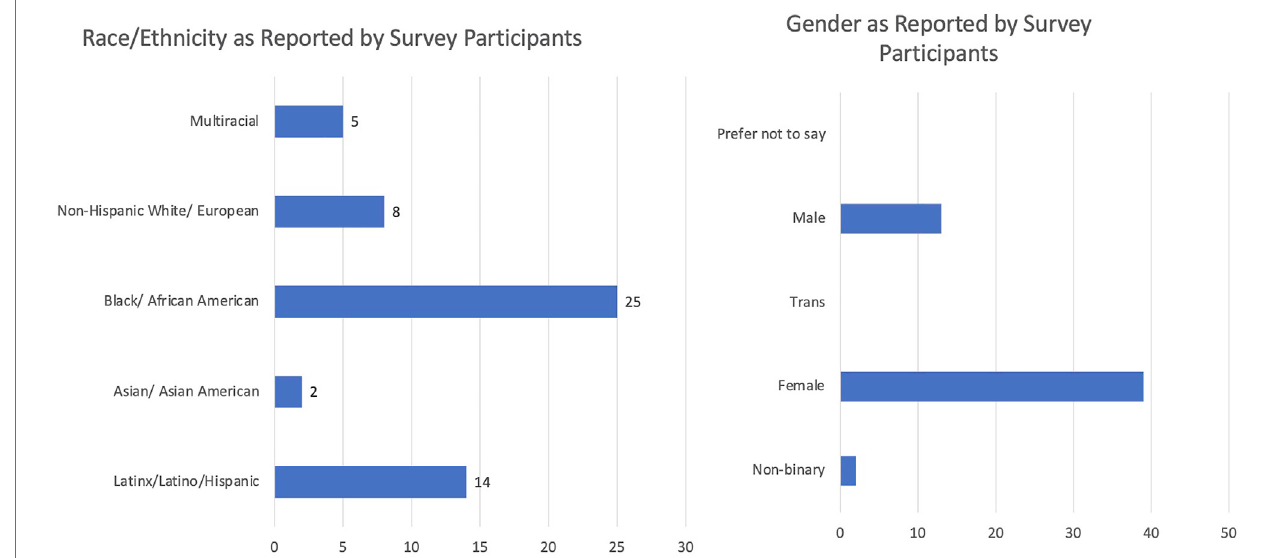
FIGURE 1 | Gender and